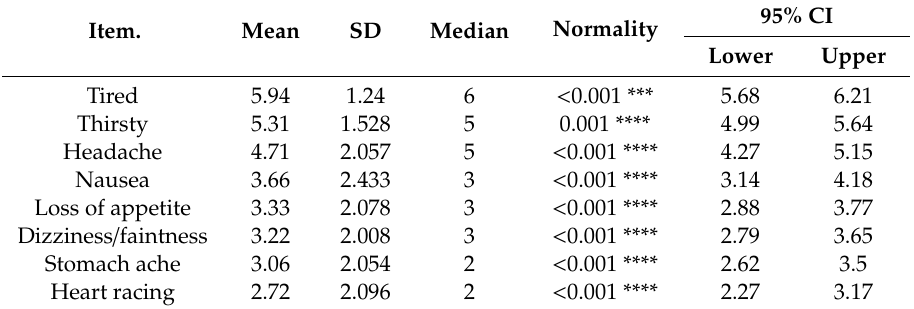
Table 1. Descriptive statistics for ratings of hangover symptom severity on the acute hangover scale (AHS).